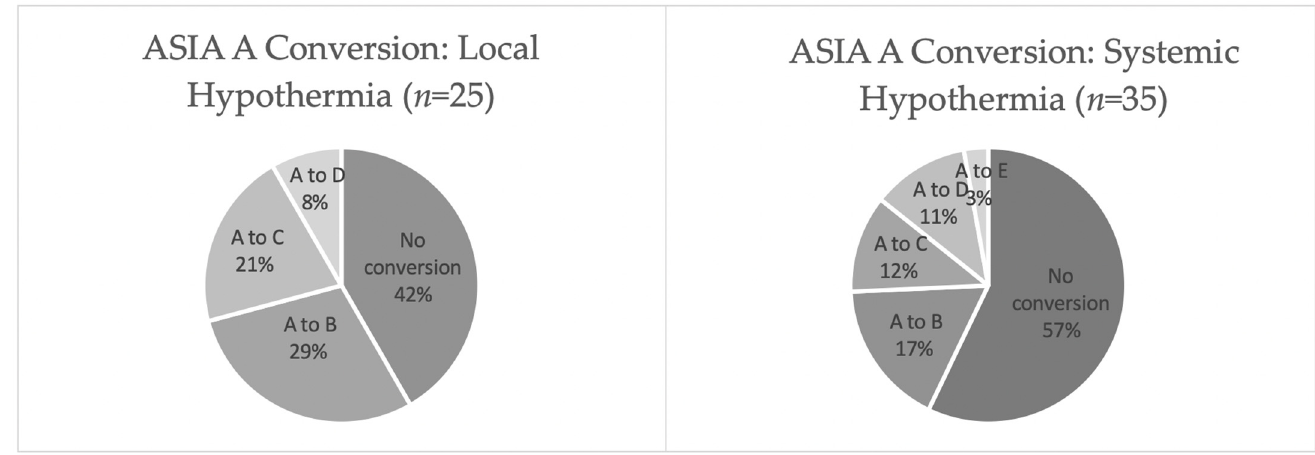
Figure 2. ASIA score conversion in individuals with TSCI who received hypothermia therapy.